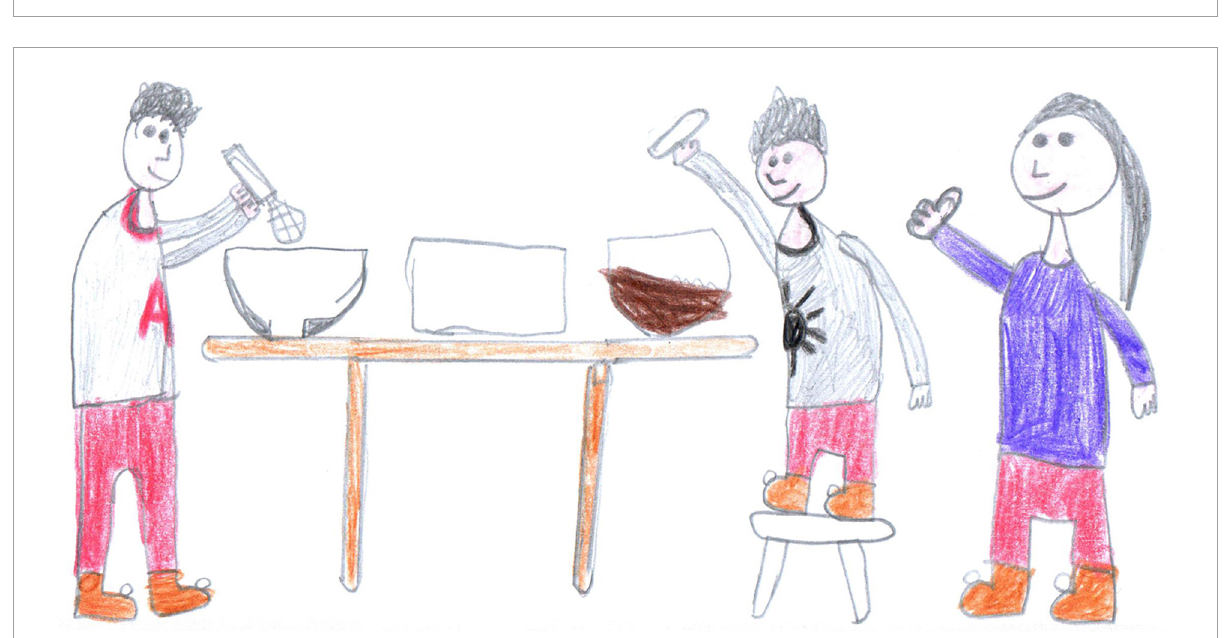
FIGURE8 Domestic chores, two children helping in the kitchen (SS, Male, 11 years).